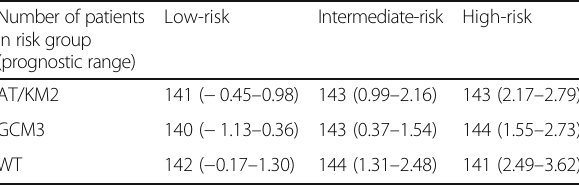
Table 7 Total number of patients and percentage that change risk-stratification